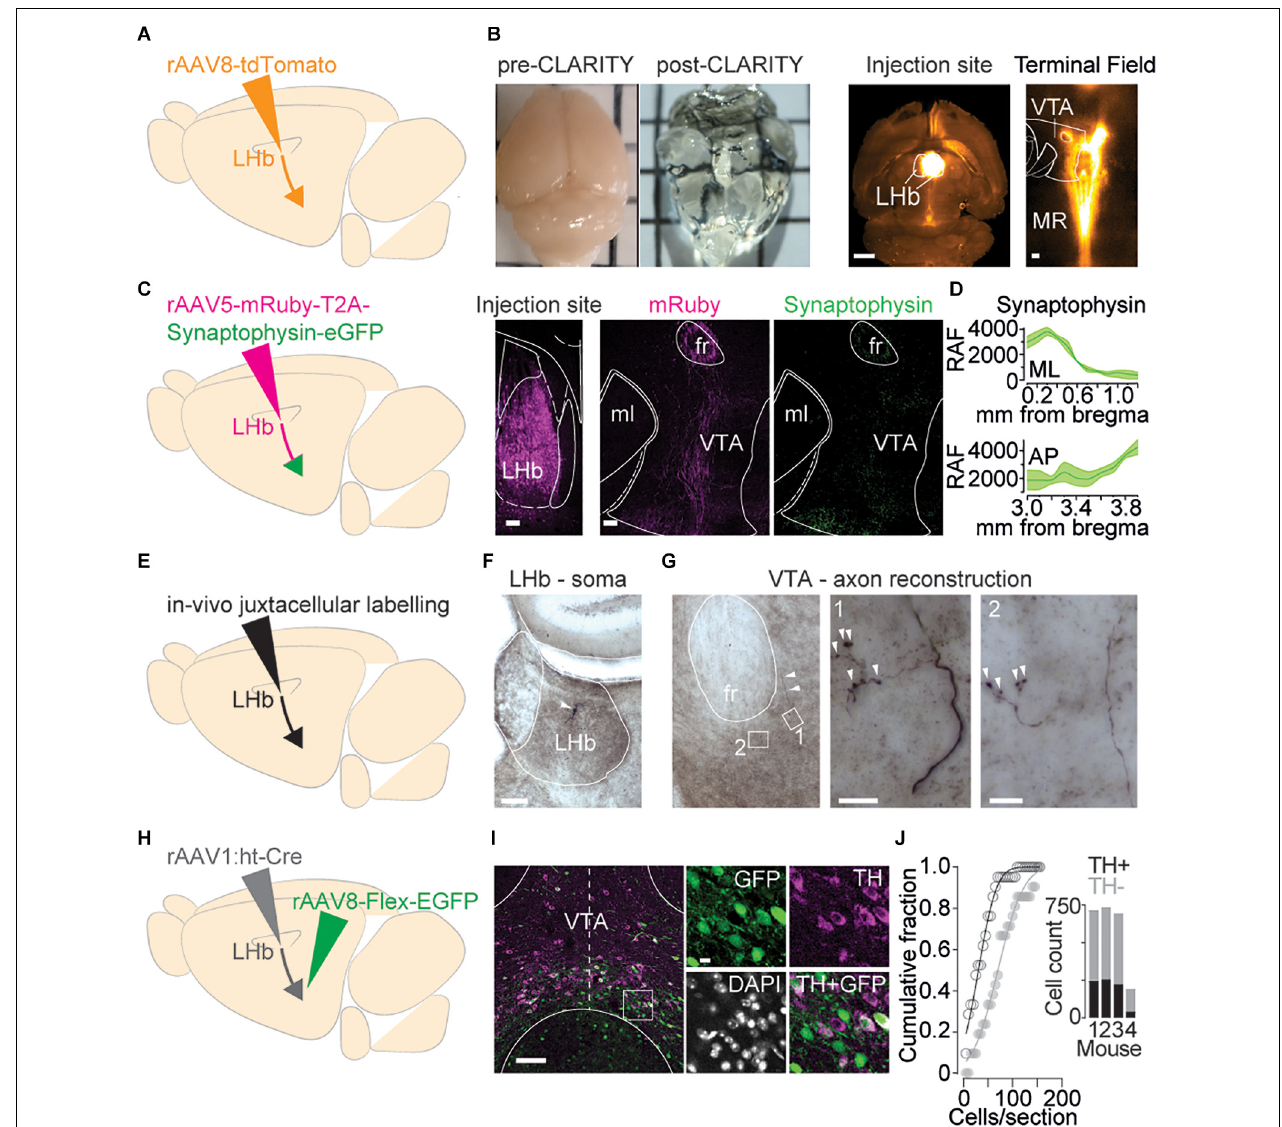
FIGURE 1 | Axons from the LHb innervate midbrain cell populations. (A) Viral strategy to visualize wholebrain projectome of LHb. (B) Left: Examples of a mouse brain before and after clarification treatment. Right: Representative images (horizontal plane) of LHb viral injection site (1 mm) and tdTomato positive terminals targeting the VTA and Median Raphe Nucleus (MRN) (100 µ m). (C) Left: Viral strategy to identify LHb axon terminals in the midbrain. Right: images (horizontal plane, 100 µ m, 10 × ) left to right: injection site in the LHb; mRuby positive axons in the VTA; Synaptophysin-EGFP positive terminals in the VTA. (D) Quantification in Relative Arbitrary Fluorescent (RAF) Units of Synaptophysin expression throughout the mediolateral (ML, top) and Anterior-Posterior (AP, bottom) extent of the VTA (n hemispheres / mice = 3/2) (mean ± SEM). (E) Strategy to identify individual LHb neuron axon terminal boutons in the VTA. (F) Coronal DAB-stained section showing a single LHb neuron (white arrowhead) juxtacellularly labeled in vivo (scale bar, 100 µ m). (G) Left: DAB-stained section showing a single LHb axon (white arrowheads) emerging from fr into VTA (scale bar, 100 µ m). Center and right, Maximum intensity z-stack projections of close-up magnifications (1 and 2) showing synaptic boutons within the VTA (white arrowheads) (scale bars, 10 µ m). (H) Viral strategy to label LHb receiving neurons in the VTA. (I) Left: Representative image (coronal plane, dashed midline, 100 µ m, 20 × ) of LHb receiving cells in the VTA (green) and TH + neurons (violet). Right: Close ups showing degree of colocalization of GFP and TH (10 µ m). (J) Cumulative probability distribution (KS test, p = 0.0063) for the entire population of counted cells of each section; TH + (black) and TH– (gray). Inset, total cell counts for individual mice ( n = 4). MR, Median Raphe; ml, medial lemniscus; fr, fasciculus retroflexus; RAF, Relative Arbitrary Fluorescence units; ML, Medial-Lateral; AP, Anterior-Posterior; GFP, Green Fluorescence Protein; TH, Tyrosine